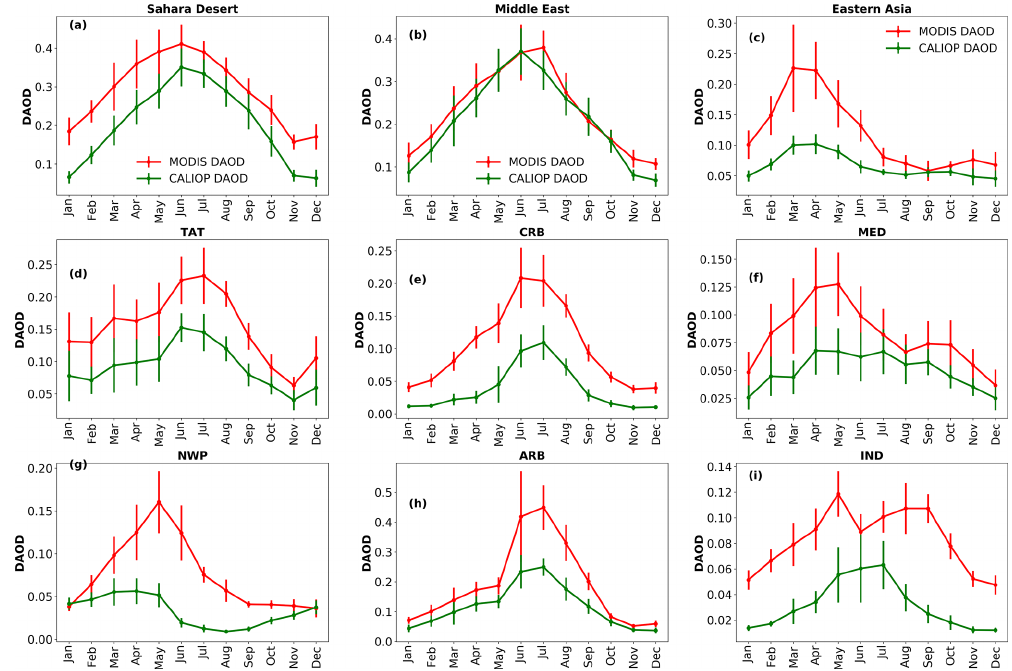
Figure 10. Monthly variation of DAOD from CALIOP (green) and MODIS (red) for major dust-laden regions indicated in Fig. 4. The vertical line represents ± 1 σ (standard deviation) over the 13-year